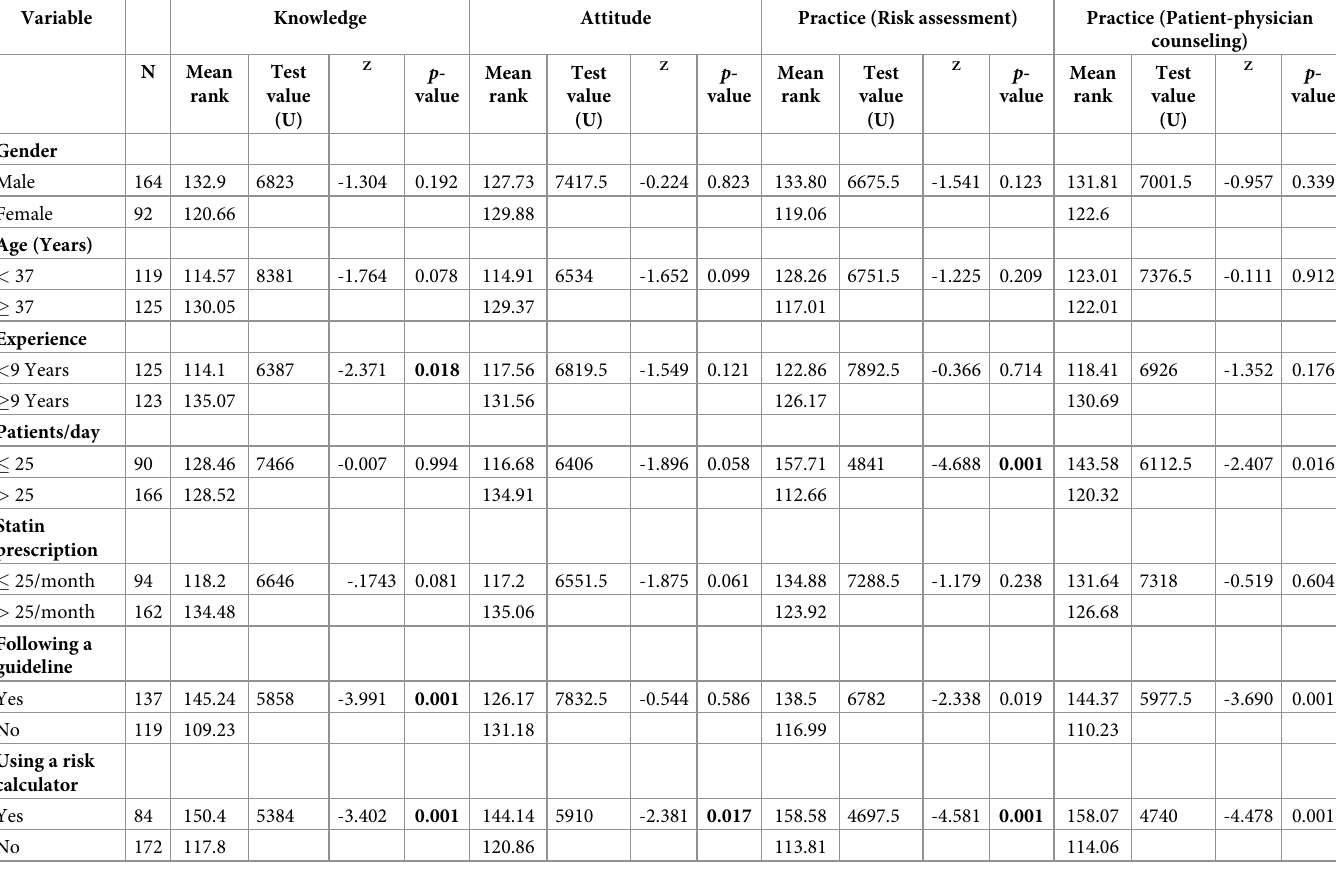
Table 4. The data of the Mann-Whitney U test for the association between demographic variables (with two categories) and physicians’ knowledge, attitude, and practices.